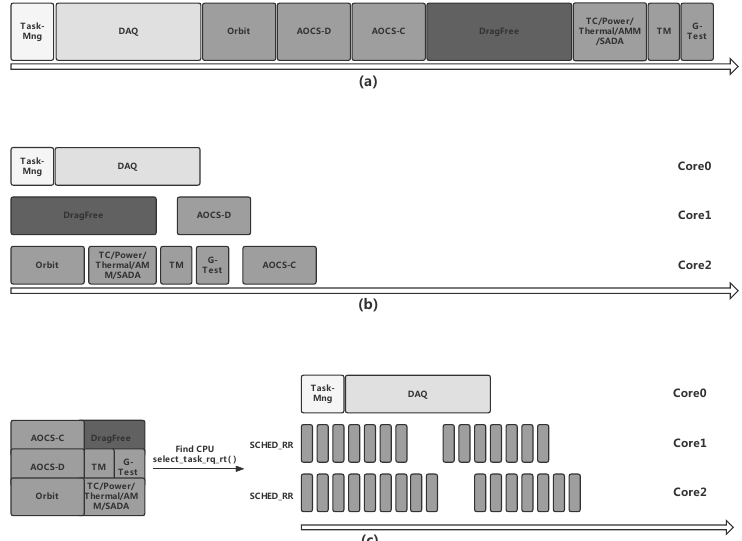
Figure 12. Comparison of scheduling schemes for application experiment. ( a ) Single-core scheduling scheme. ( b ) Static scheduling scheme. ( c ) Our scheduling scheme.